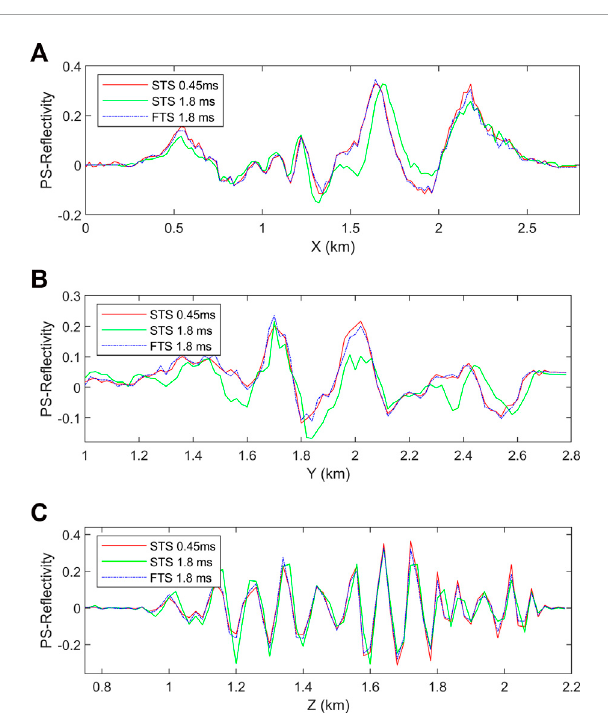
FIGURE 17 PS image pro fi les at (A) ( y , z ) = (1.6, 0.8) km, (B) ( x , z ) = (1.4, 1.8) km and (C) ( x , y ) = (2.0, 1.0) km via ERTMs using the STS and FTS methods.